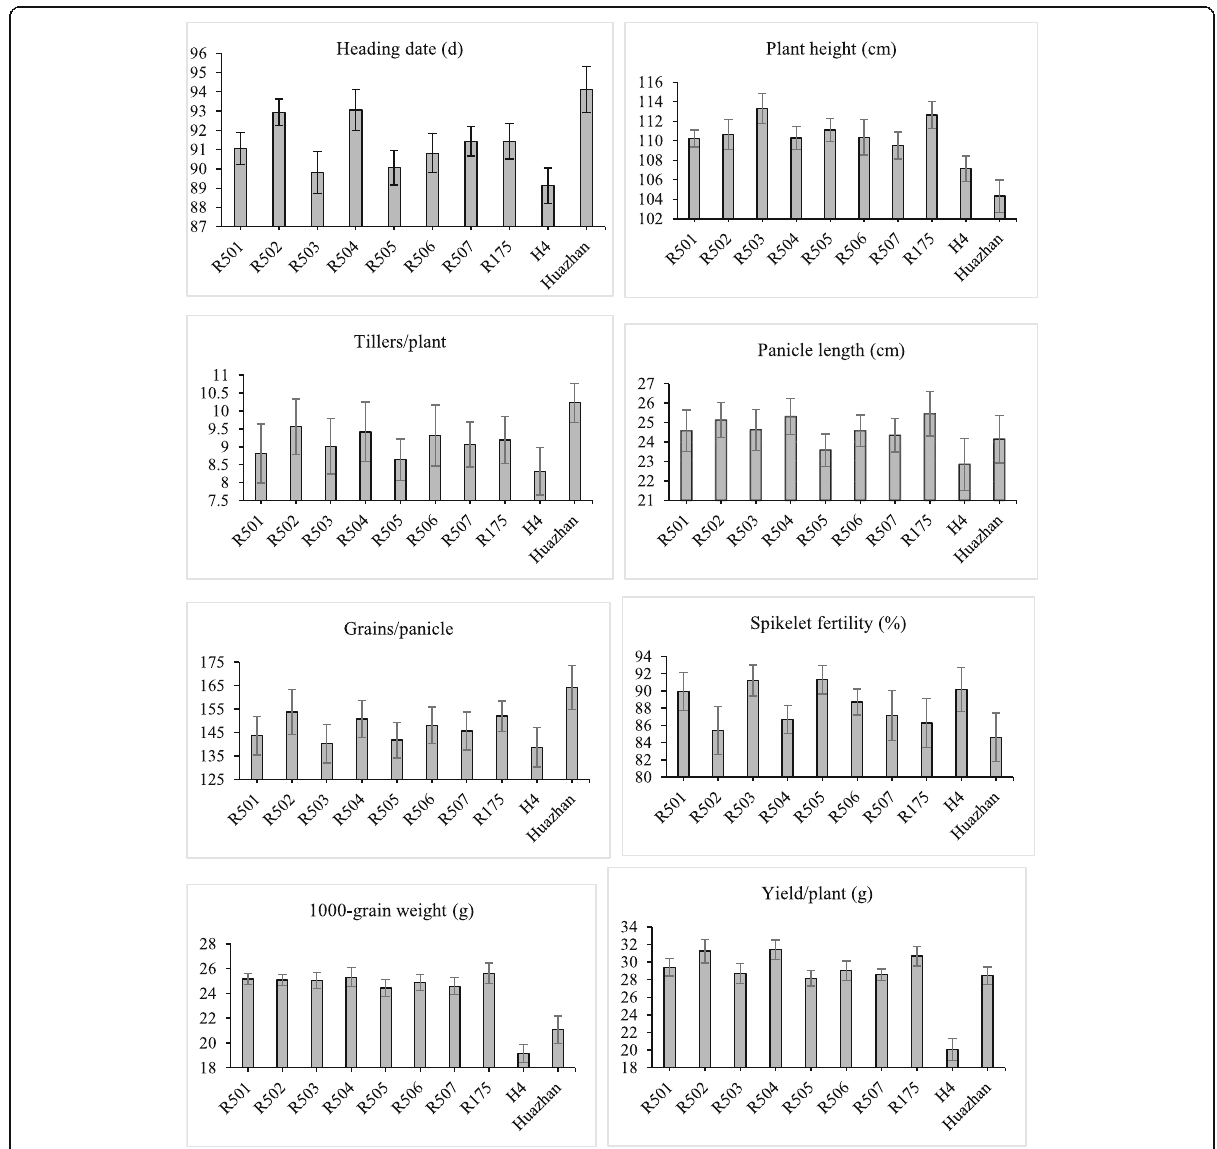
Fig. 2 Performances of main agronomic traits of the tested lines during the early crop season (March to July) of